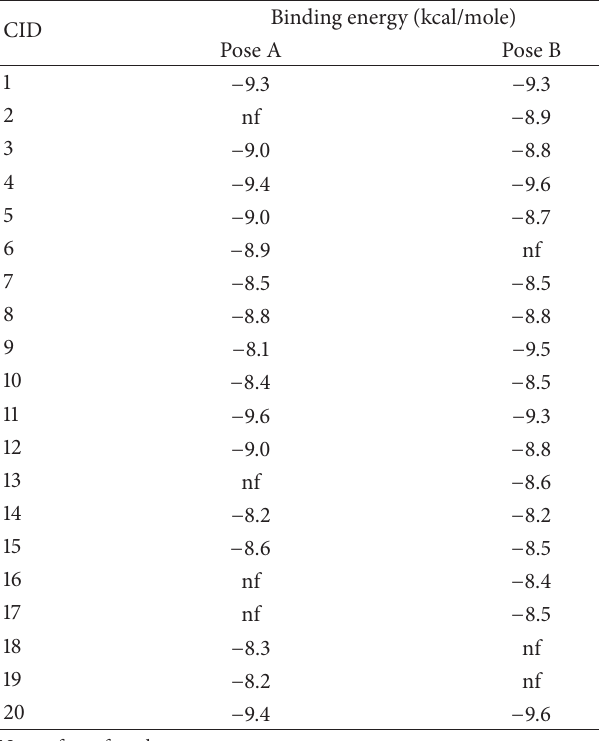
Table 2: Binding energy of dicoumarols.